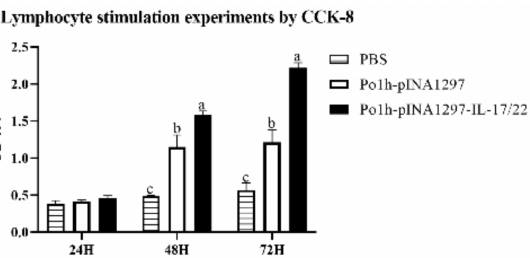
Figure 3. Cell viability analysis via CCK8. The data with different lowercase letter are significantly different, p < 0.05, and the following are the same as